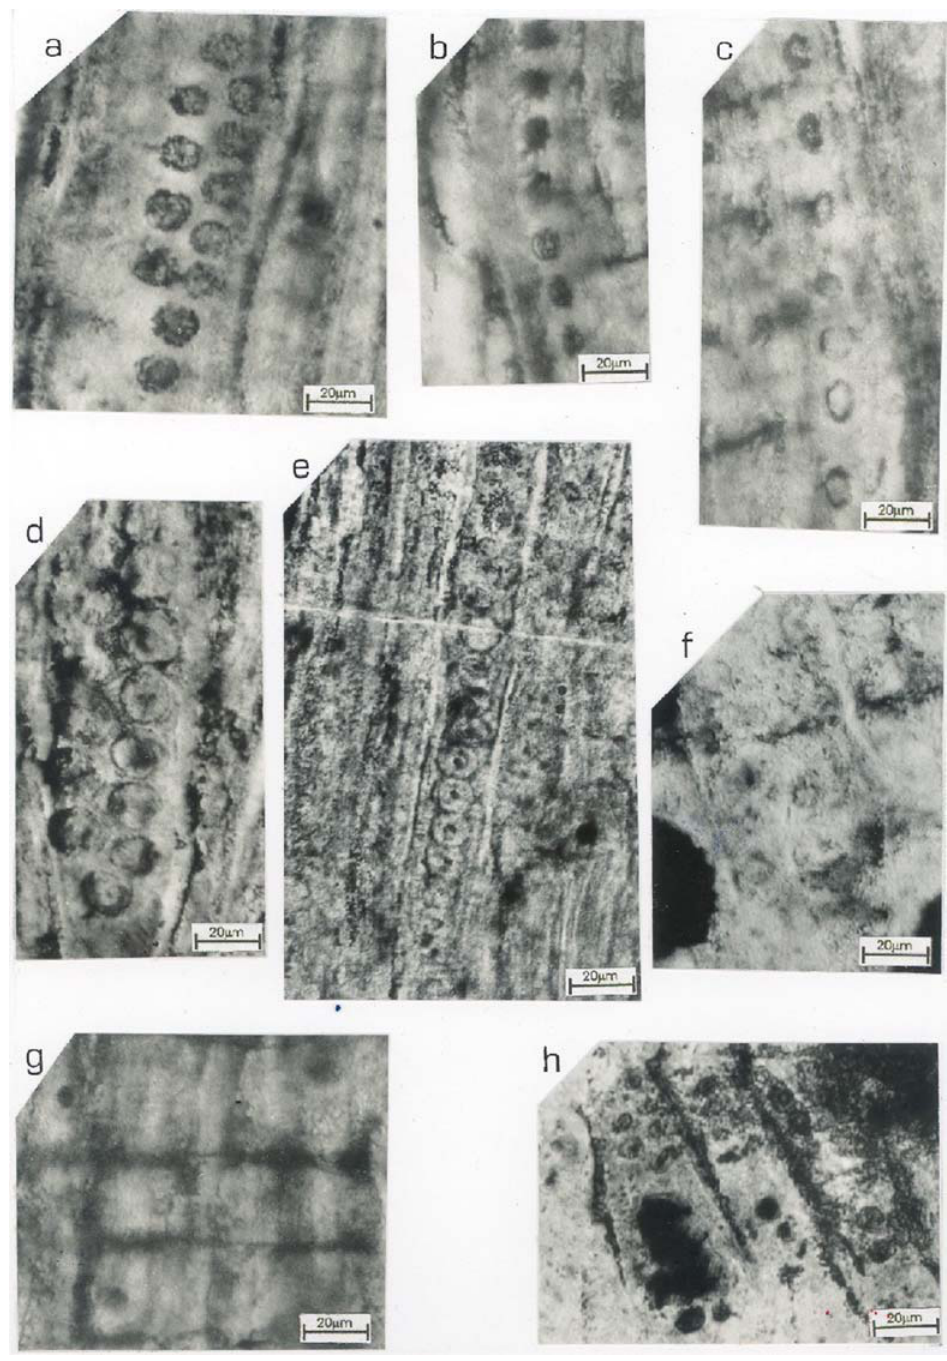
Fig. 2 – Sommerxylon spiralosus n.gen. et n.sp. Radial section a: tracheid with bordered pits partially biseriate alternate. b: tracheid with bordered pits uniseriate isolated. c: tracheid with bordered pits uniseriate isolated. d: tracheid with bordered pits partially biseriate alternate. e: tracheid with bordered pits uniseriate contiguous. f, g: cross-fields with not well preserved pits, circular. h: cross-field with 1-4 pits in irregularly